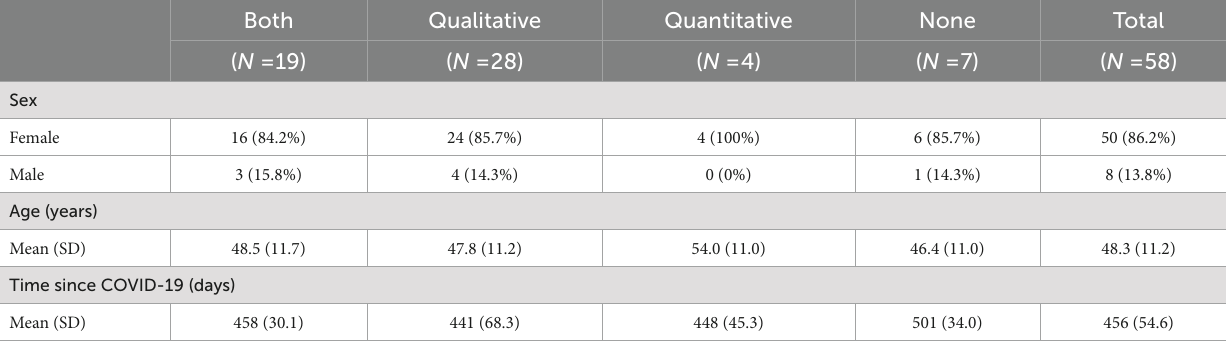
TABLE 1 Descriptive statistics of research participants.